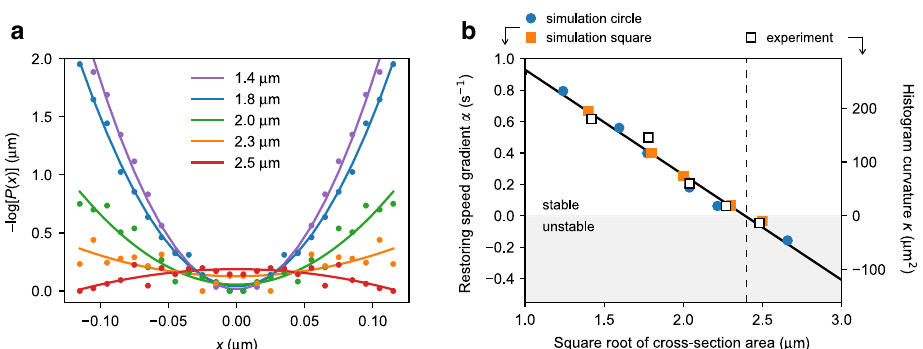
Fig. 4 Stability of the axial swimming state. a Effective potential for the cell center along the transverse coordinate in the fi ve smallest tunnels. The potential is computed as the logarithm of the cell position probability distributions shown in Fig. 2c and shows a minimum where axial swimming is stable. Each solid line plots the best quadratic fi t to experimental data. b Comparison between the curvatures of the fi tted effective potential κ (white squares) and the restoring speed gradient α (see Eq. (1)) obtained from numerical simulations. Orange squares and blue circles plot simulations results for tunnels with square and circular section respectively.